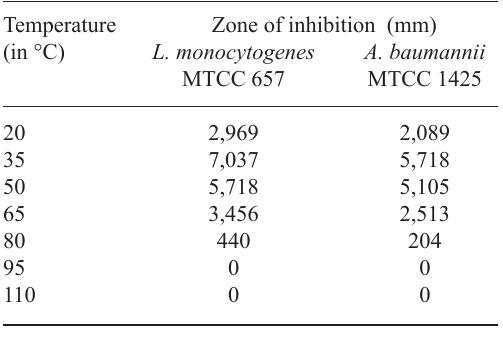
Table 5. Effect of surfactants on the antimicrobial